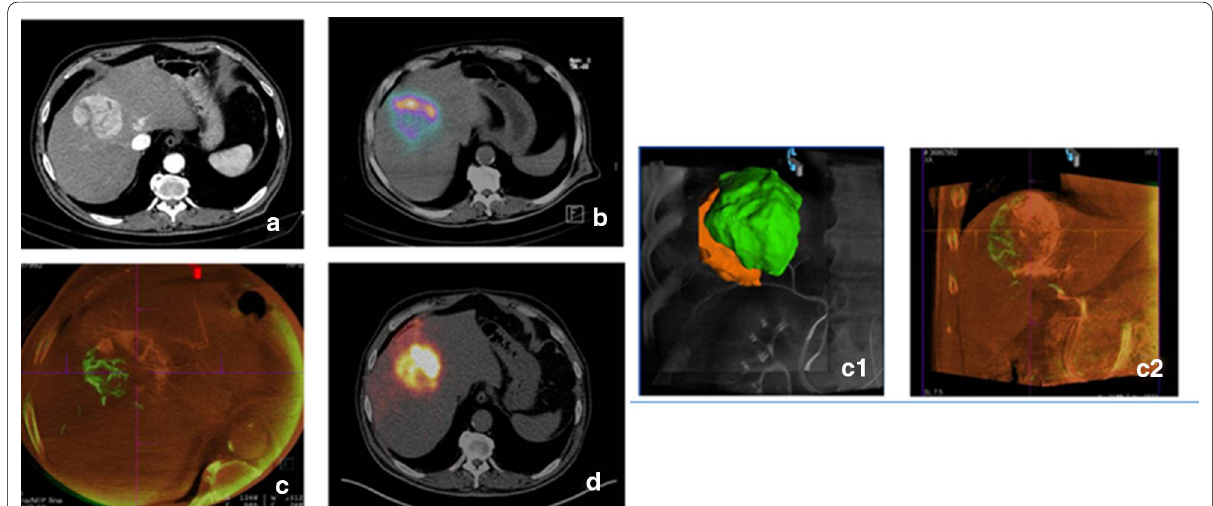
Fig. 4 Same patient as Fig. 1. a Contrast‑enhanced computed tomography (CECT) image: HCC located between segments IV and VIII. b 99m Tc‑MAA SPECT/CT fusion image shows low uptake in the lateral part of the tumoral nodule. 99m Tc‑MAA activity was split in two doses of 50% each by IR decision, based on liver and tumoral volumes. c, c1 and c2 C‑arm cone‑Beam CT (CBCT) volumetric assessment of the tumoral territory perfused by each artery. VIII segments artery (in green) fed only 32% of the tumoral volume while IV segment artery fed most of it (in orange). d 90 Y PET/CT fusion image after splitting the activity according to CBCT volumes shows the adequate distribution of the microspheres throughout the